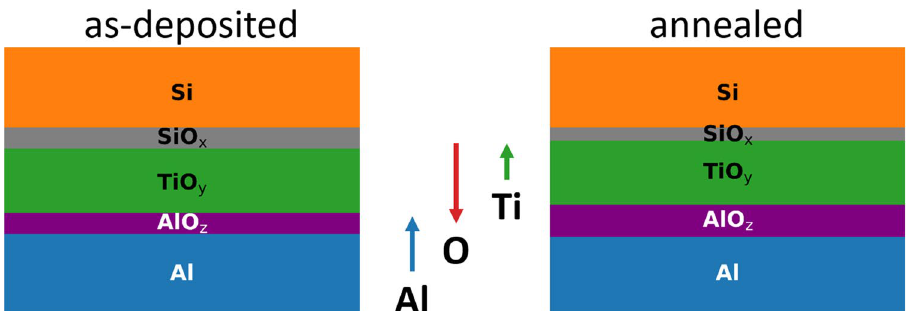
Figure 4. Schematic summary of observed layers (thicknesses are not to scale) and diffusion fluxes (arrows). ‘Si’ and ‘Al’ denote the silicon substrate and the aluminum rear contact, respectively. ‘SiO x ’ is the passivating silicon oxide, which contains Ti. ‘TiO y ’ denotes the titanium oxide layer moving towards the substrates as a result of titanium and oxygen diffusion; moreover, stronger oxygen deficiency is observed after annealing. ‘AlO z ’ denotes the aluminum oxide layer being already present in the as-deposited sample; annealing leads to further oxidation and partial removal of titanium. Finally, ‘Al/AlO z ’ denotes the interface between aluminum and aluminum oxide; according to EELS data it can be viewed as a superposition of the two adjacent